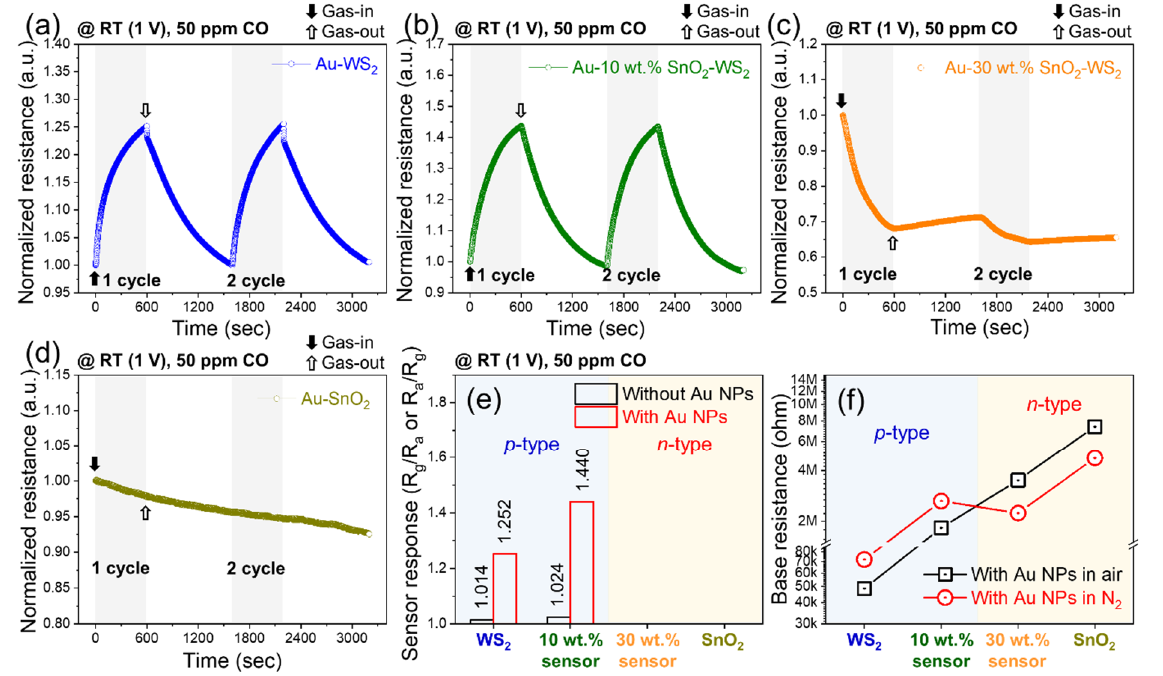
Figure 4. ( a – d ) Normalized dynamic resistance plots of different gas sensors to 50 ppm CO at room temperature (20 ◦ C) under 1 V applied voltage. Comparison between the ( e ) sensor response and ( f ) base resistance of WS 2 NS, 10 wt% SnO 2 –WS 2 , 30 wt% SnO 2 –WS 2 , and SnO 2 NS gas sensors with Au NPs decoration in air and N 2 atmosphere.